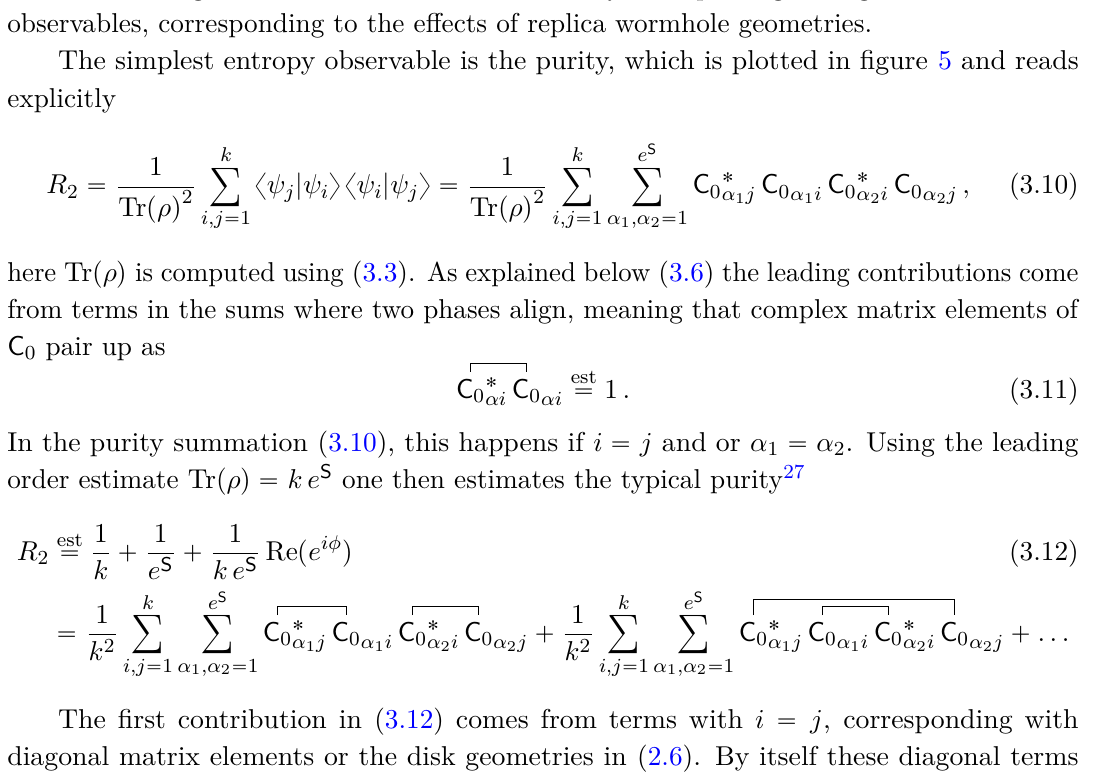
k L (orange), log-log 1 { (cid:0) {